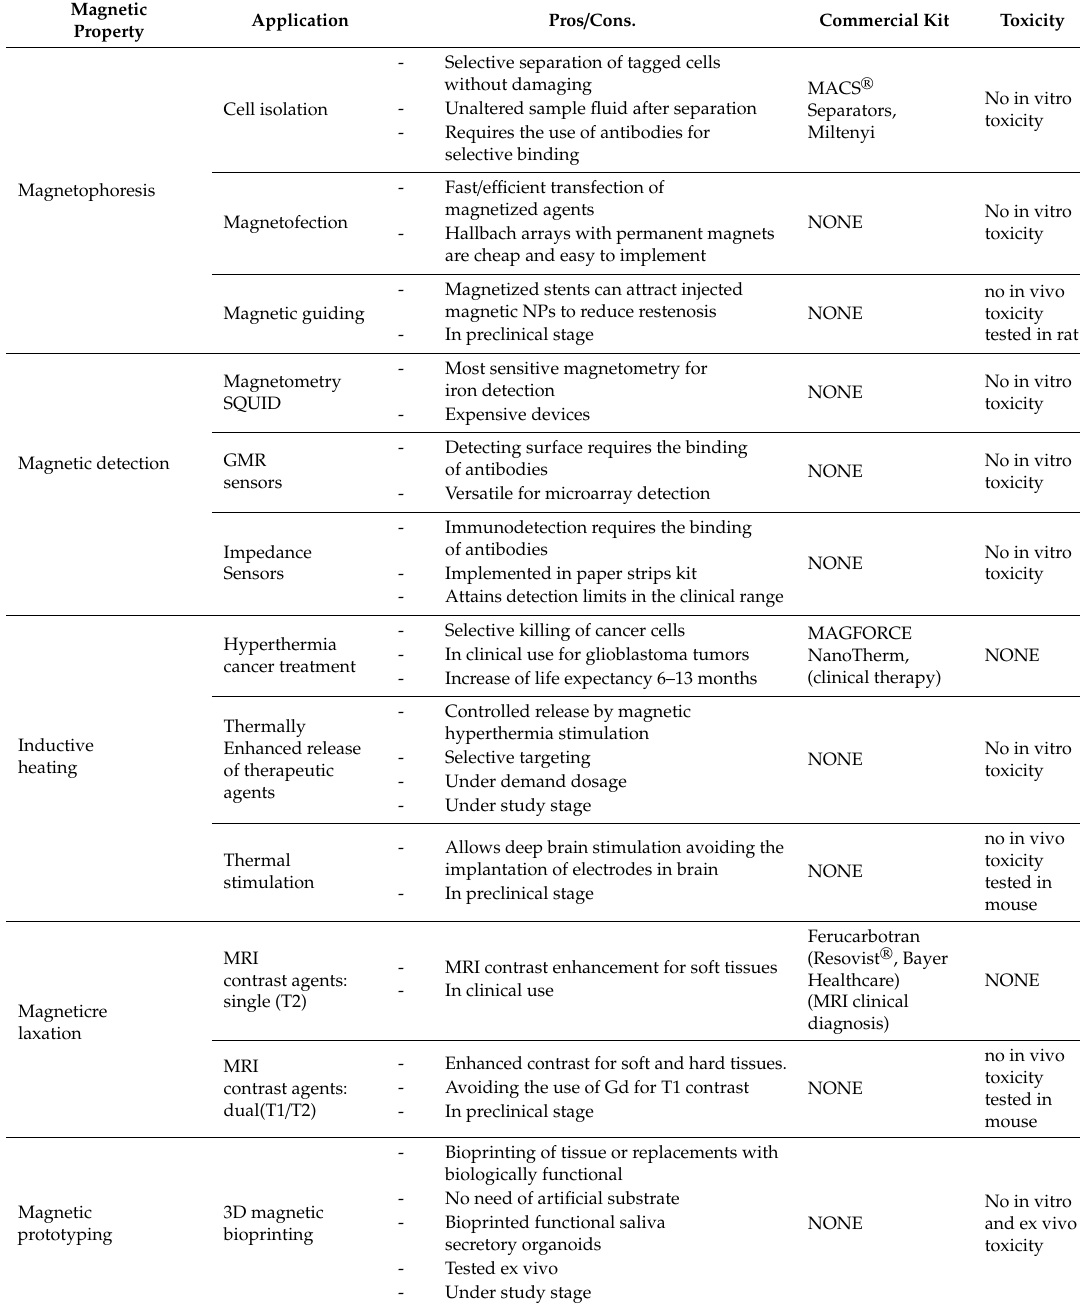
Table 2. Summary of biomedical applications based on the combination of SPIONS and magnetic